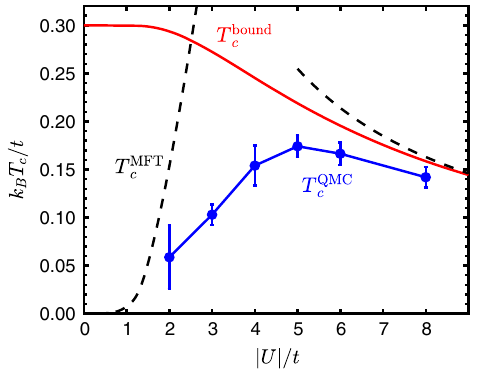
FIG. 2. T c for the 2D attractive Hubbard model at density n ¼ 0 . 7 with QMC results from Ref. [30]. The BCS mean-field T MFT controls T c at weak coupling. Phase fluctuations, estimated using our upper bound T bound c (see text), dominate at intermediate and strong coupling, where we also show the t 2 = j U j asymptotics of our